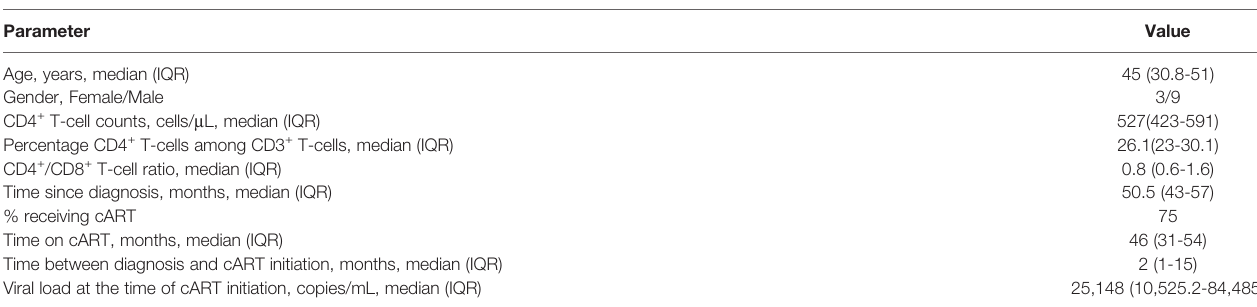
IQR, interquartile range; cART, combination antiretroviral